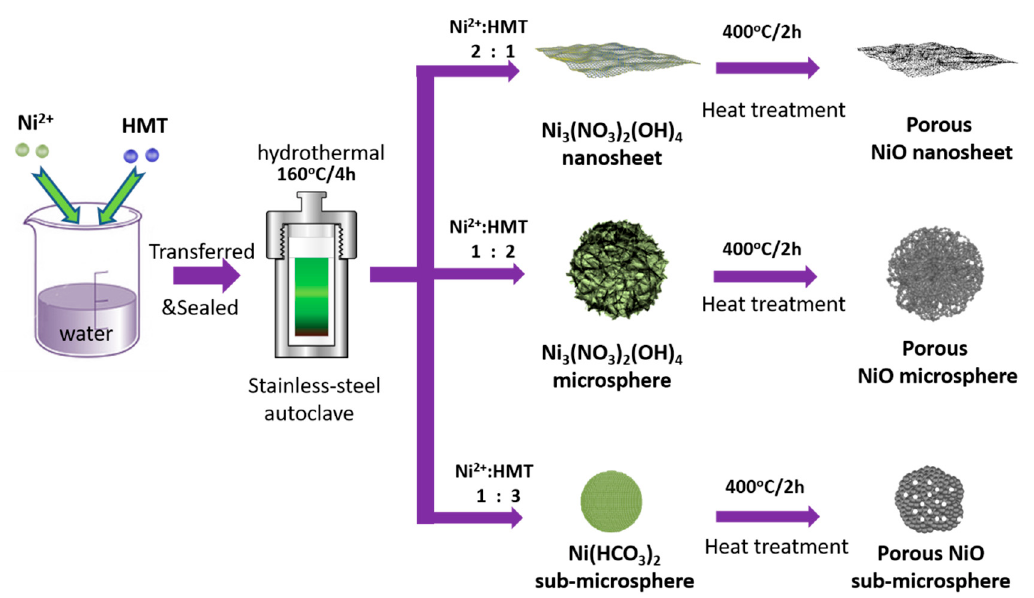
Figure 6. The synthesis route of hydrothermal reaction and subsequent calcination for mesoporous NiO hierarchical nanostructures.